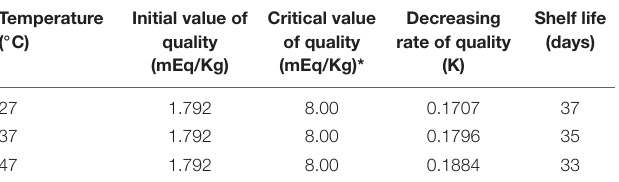
TABLE 7 | Estimation of sagon shelf life*